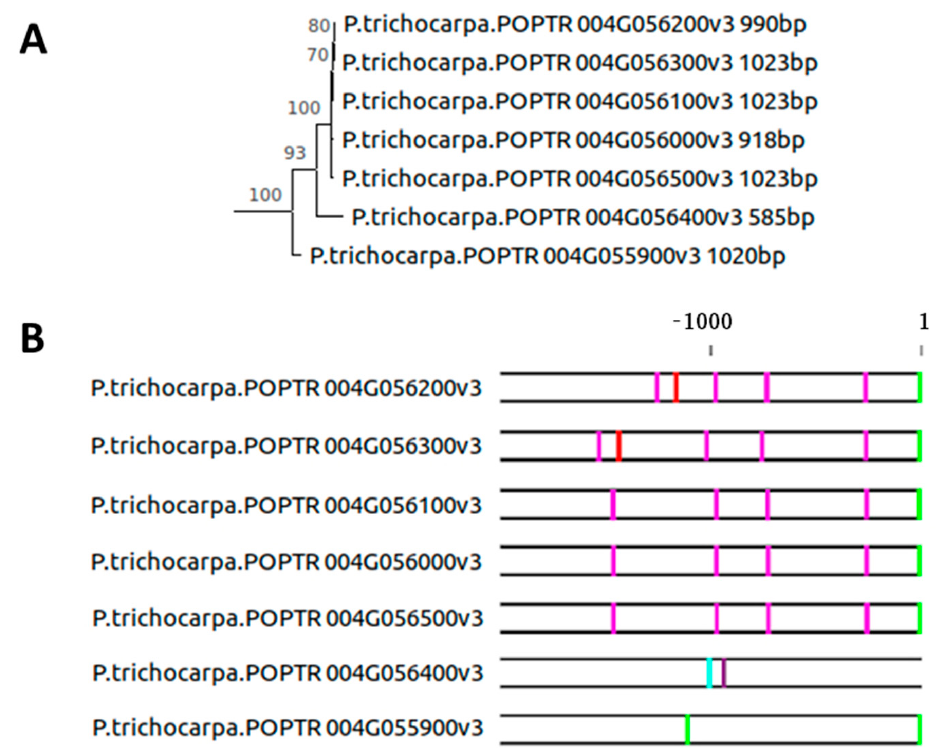
Figure 4. Phylogenic analyses of SAG12 and its promoter region in Populus trichocarpa . ( A ) Phylogeny of SAG12 coding sequence indicating species, gene identification, and sequence length and ( B ) 2000 bp region adjacent to the ATG start codon annotated for the presence of W-boxes (T/C TGAC T/C), A-boxes (TACGTA), T-boxes (AACGTT), C-boxes (GACGTA), and G-boxes (CACGTA). W-boxes in sense (Pink), W-boxes in anti-sense (Purple), A-boxes (Green), T-boxes (Cyan), and G-boxes (Red).